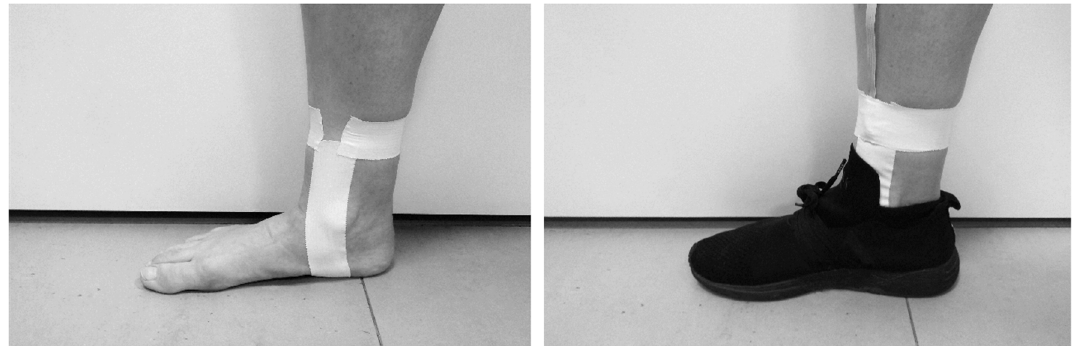
Figure 2. Attachment method of the sensor to the lower leg. (left) Pretension is applied to the skin near the site of attachment. (right) The accelerometer is firmly fixed with